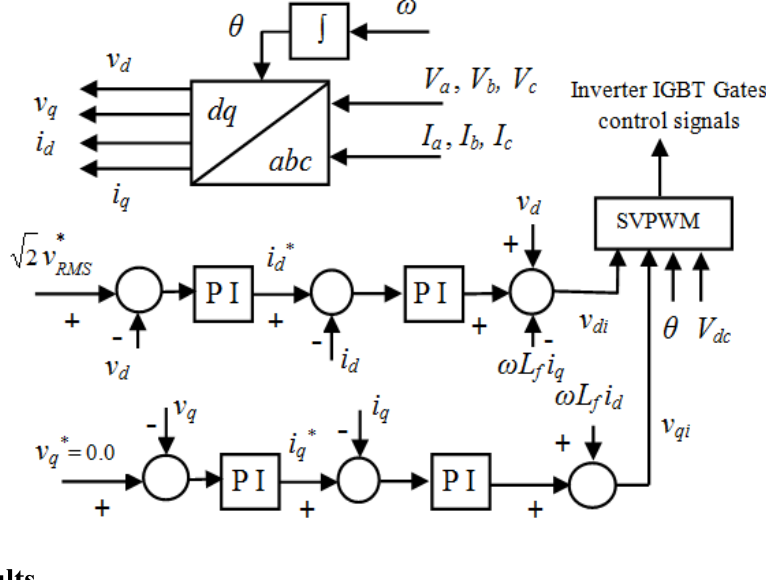
Figure 9. The load side voltage source inverter control strategy